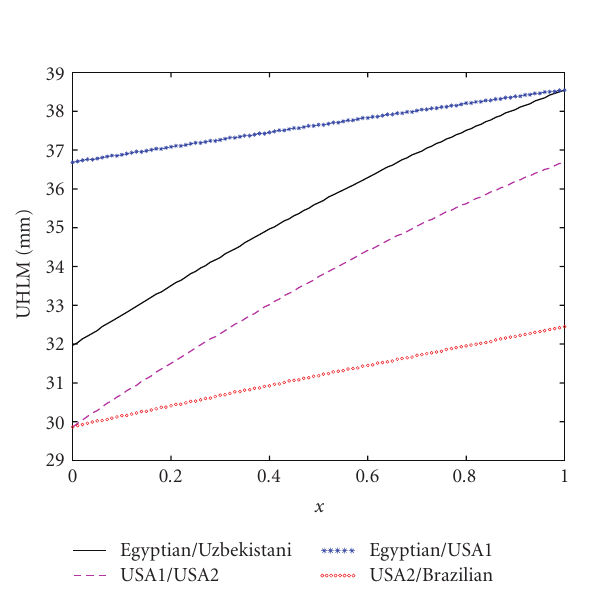
Figure 3: DUQL dependence to x .